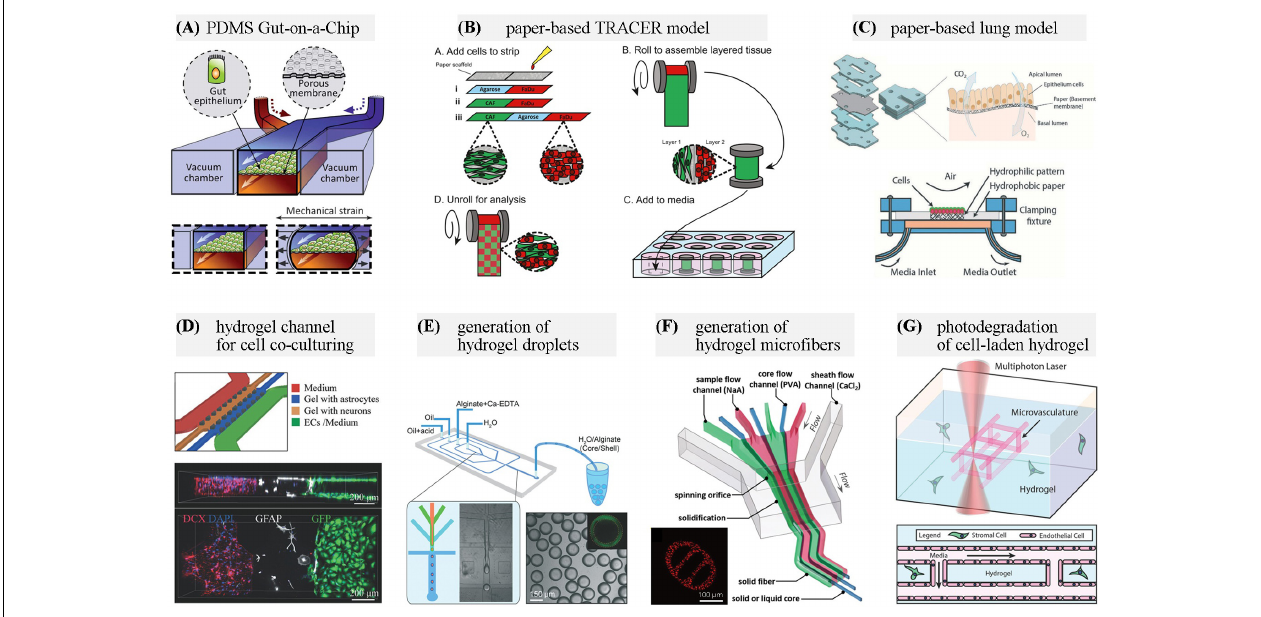
FIGURE 1 | Representative materials used for OOC applications. (A) A PDMS gut-on-a-chip device containing two microchannels separated by a flexible porous membrane, and vacuum chambers on both sides. Adapted with permission from Kim et al. (2012), The Royal Society of Chemistry. (B) Configuration of a paper-based Tissue Roll for the Analysis of Cellular Environment and Response (TRACER) platform. Adapted with permission from Young et al. (2018), Elsevier. (C) Paper-based air-liquid-interface for in vitro human respiratory system model. Adapted with permission from Rahimi et al. (2016), The Royal Society of Chemistry. (D) A neurovascular chip with gel channels for cell co-culturing. Adapted with permission from Adriani et al. (2017), The Royal Society of Chemistry. (E) Generation of core-shell hydrogel droplets for spheroid-based liver model. Adapted with permission from Chen Q. et al. (2016), The Royal Society of Chemistry. (F) On-chip spinning of hydrogel microfibers with morphological and structural complexity, as well as a heterogeneous composition. Adapted with permission from Yu et al. (2016), John Wiley & Sons. (G) Microchannel generation within cell-laden hydrogel by user-programmed multiphoton excitation induced localized degradation. Adapted with permission from Arakawa et al. (2017), John Wiley &